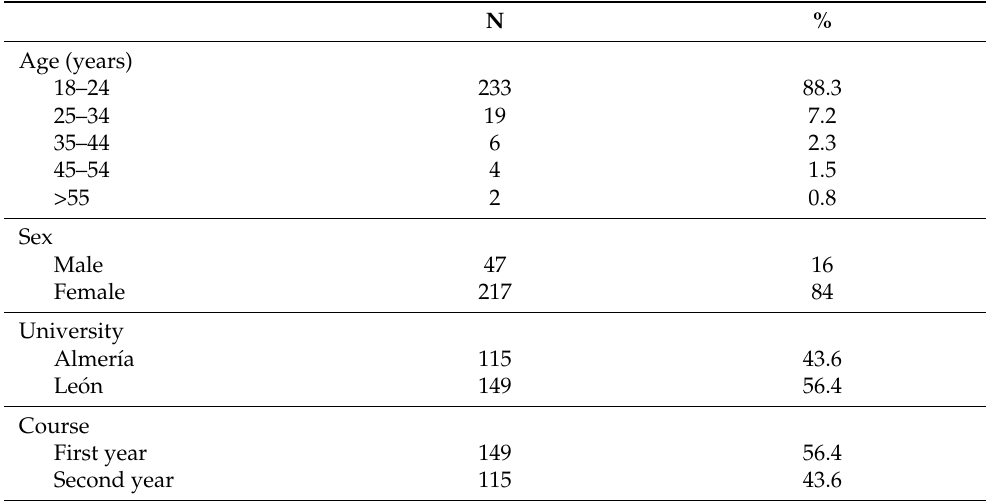
Table 1. Characteristics of the participants (N =